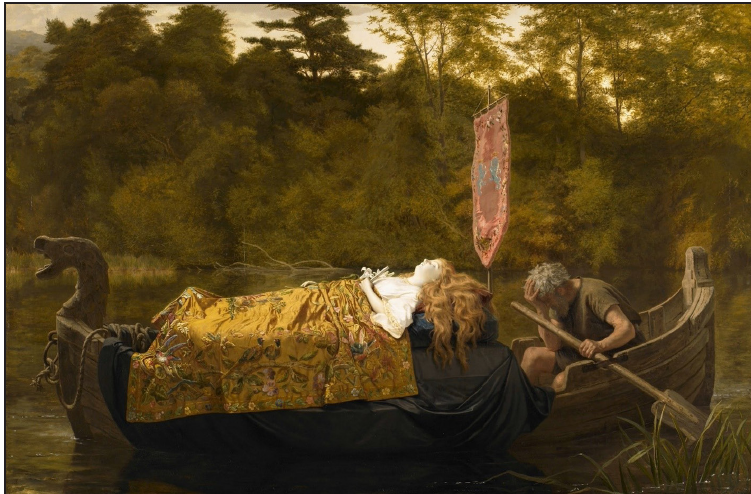
Fig. 8 : Sophie Anderson, Elaine , 1870, oil on canvas, 158.4 × 207 cm, Walker Art Gallery, Liverpool. Wikimedia